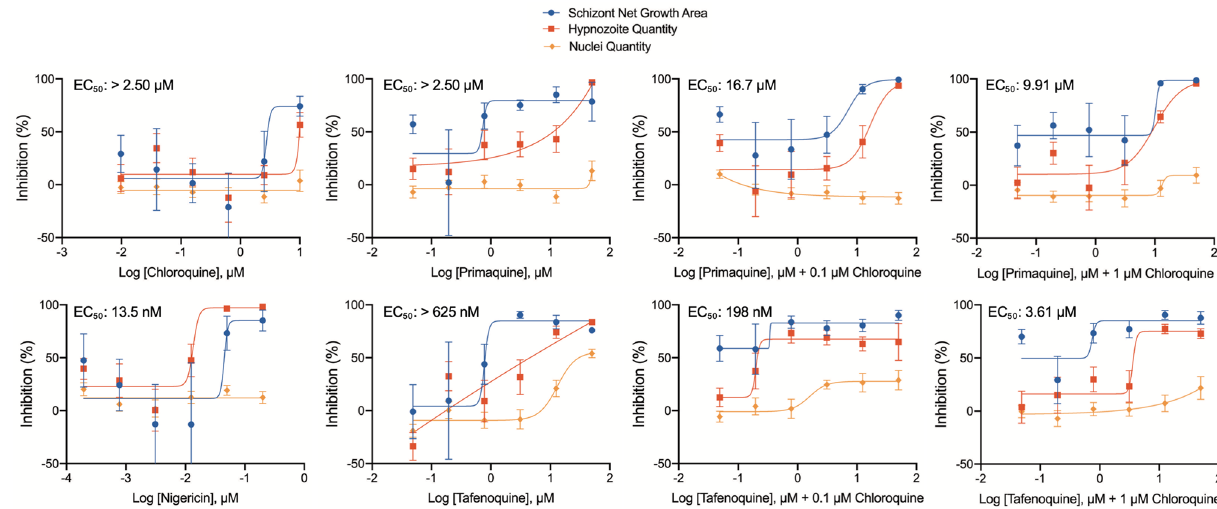
Figure 3. Demonstration of 8AQs synergy with chloroquine in vitro using a 20-day assay. Chloroquine, primaquine and tafenoquine were assayed in the 20-day assay format alone and in combination with chloroquine as indicated on the X-axis. Chloroquine was found slightly toxic at 10 μM, thus the 0.1 and 1 μM combinations with 8AQs are shown. Nigericin was ran in all assays as a positive and normalization control. EC 50 shown indicates potency against hypnozoites. Bars represent the SEM of three independent experiments; the first two experiments were the average of two replicate wells for each concentration, the third experiment was the average of four replicate wells for each